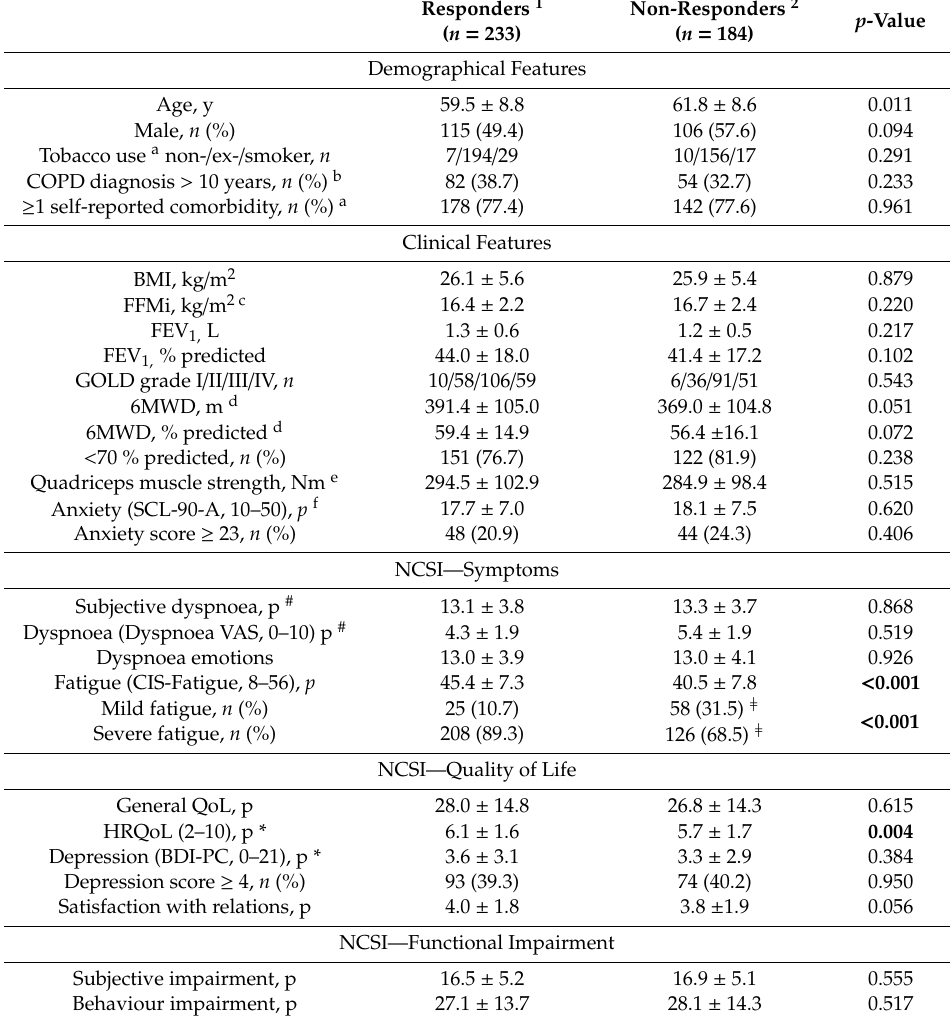
Table 3. Baseline characteristics of COPD patients stratified for response of fatigue after PR (responder analysis, n =